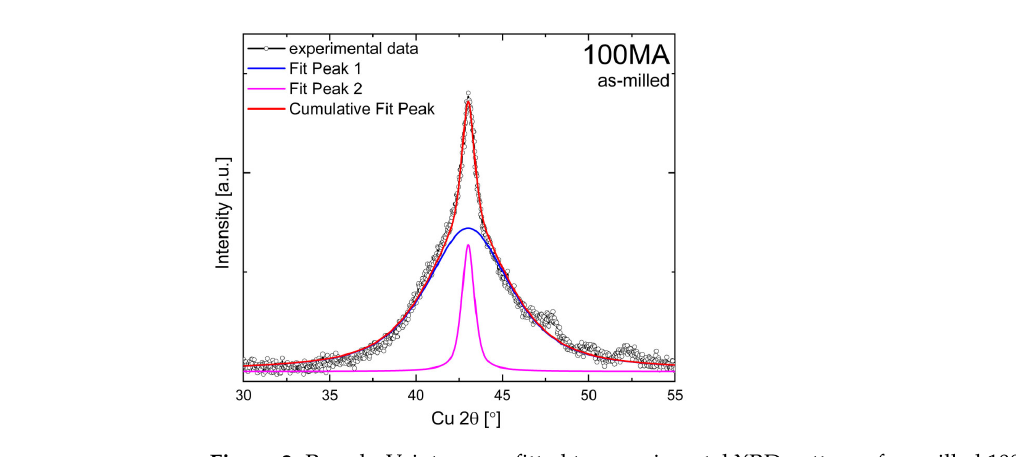
Figure 3. TEM results: ( a , d ) bright ‐ field (BF) images, ( b , e ) dark ‐ field (DF) images,( c , f ) selected area electron diffraction patterns (SAEDP) of the as ‐ milled 70MA and 100MA powders, respectively. The inset in ( a )—histogram of the crystallite size distribution.